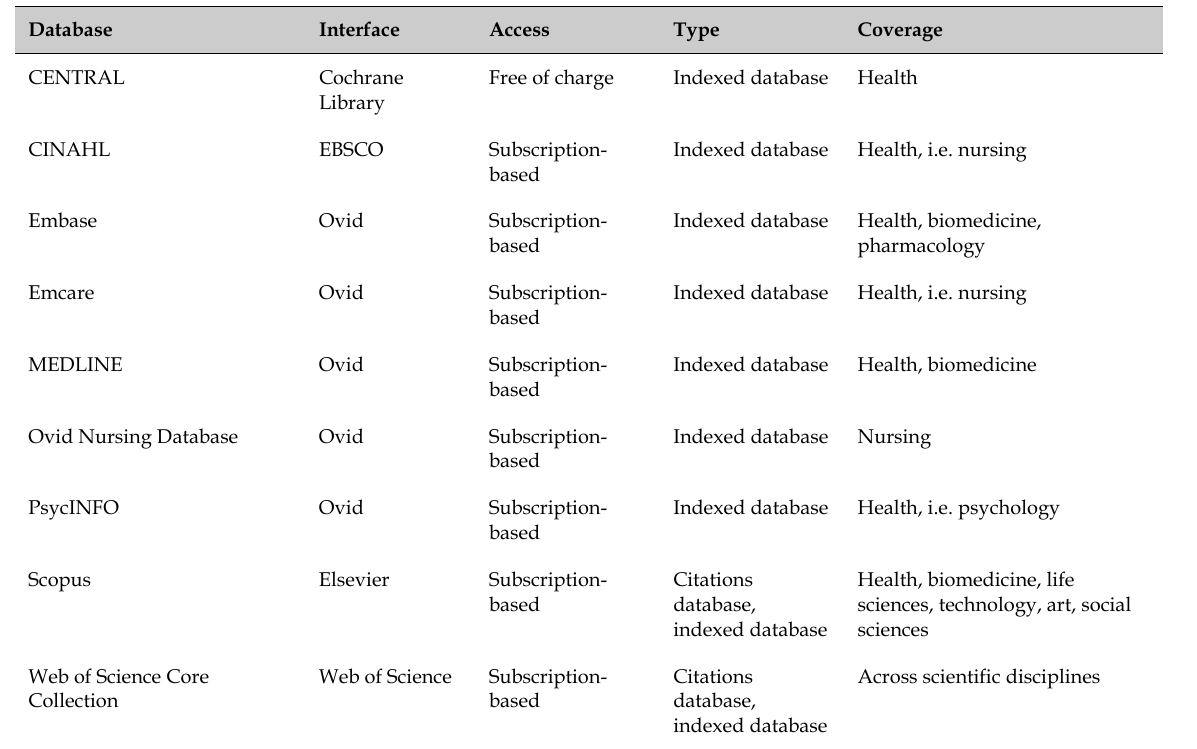
Table 1 Characteristics of retrieved